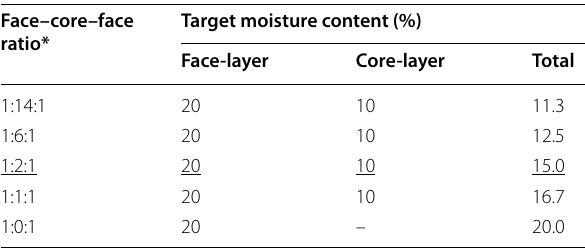
Table 2 Series of experimental mats for evaluating the effect of face–core–face (FCF) ratio Face–core–face ratio*